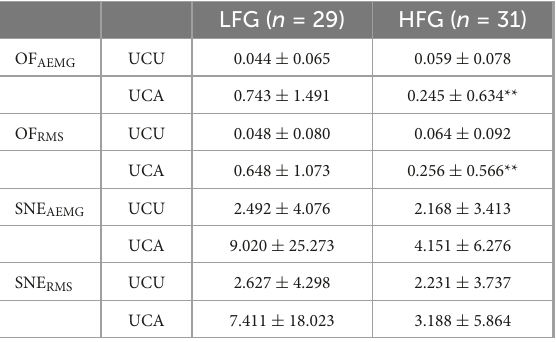
TABLE 6 Surface electromyography parameters of patients with stroke between two